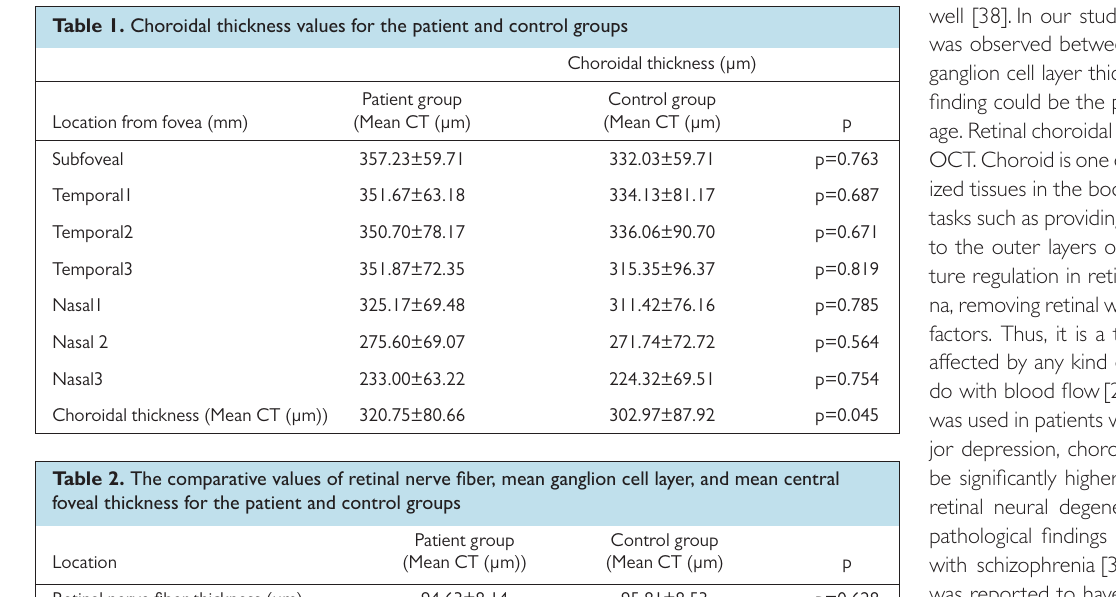
patient group and 83.68±5.75 µ (67-92) in the